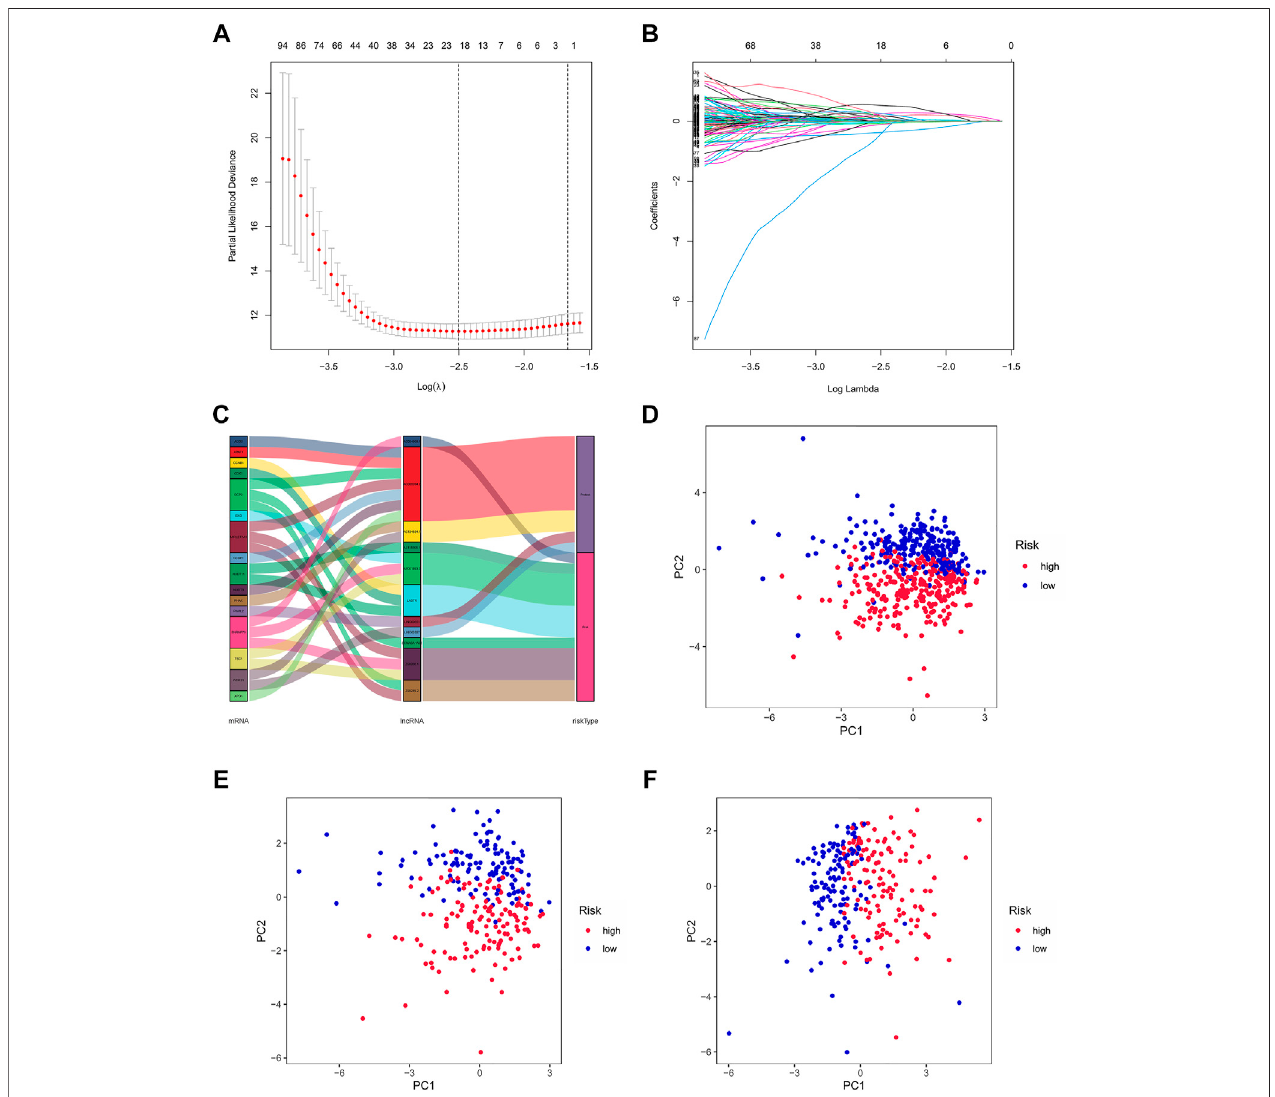
FIGURE3| Exhibitionofm7G-related lncRNAs prognostic signature inccRCC. (A) The 10-fold cross-validationfor variable selection inthe LASSOmodel. (B) The LASSO coef fi cient pro fi le of 12 m7G-related lncRNAs. (C) The Sankey diagram of m7G genes and related lncRNAs (D – F) The PCA of two risk groups in the entire set, test set and train set,